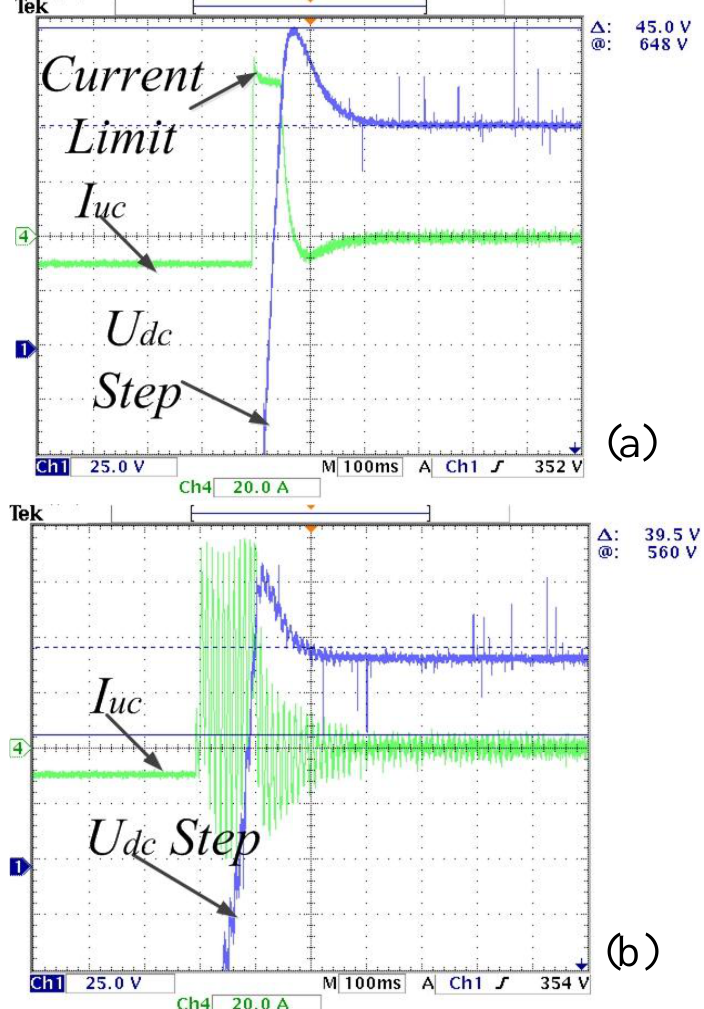
Figure 8. Dynamic response figure of the control loop: ( a ) PI regulator adopted in the DC link voltage control; ( b ) PIR regulator adopted in the DC link voltage